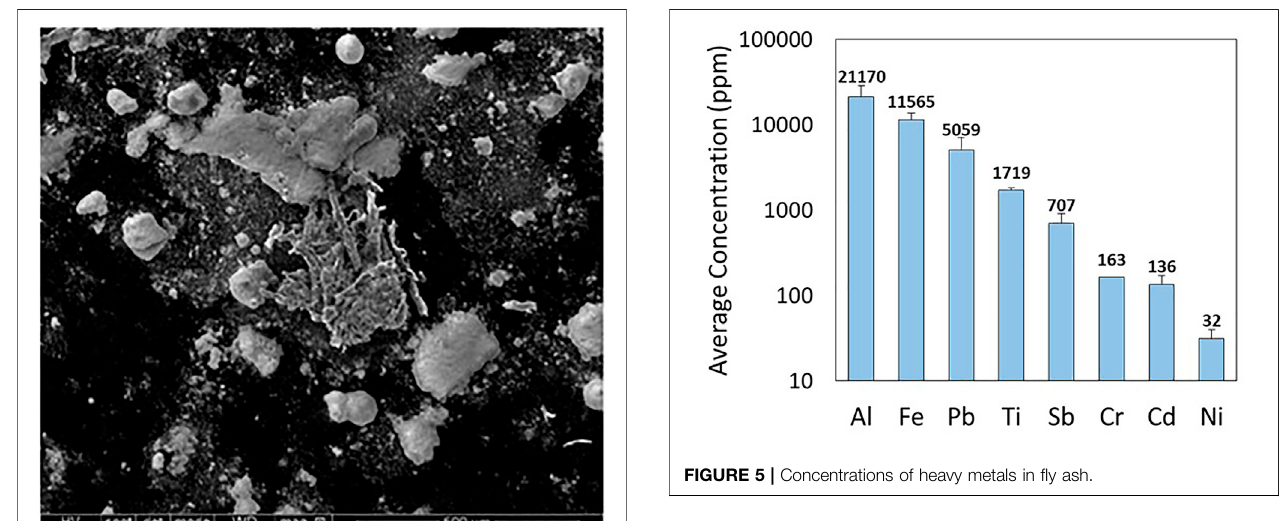
( Figure 6A ). Peaks at 2,847 cm − 1 and 2,915 cm − 1 indicate C-H